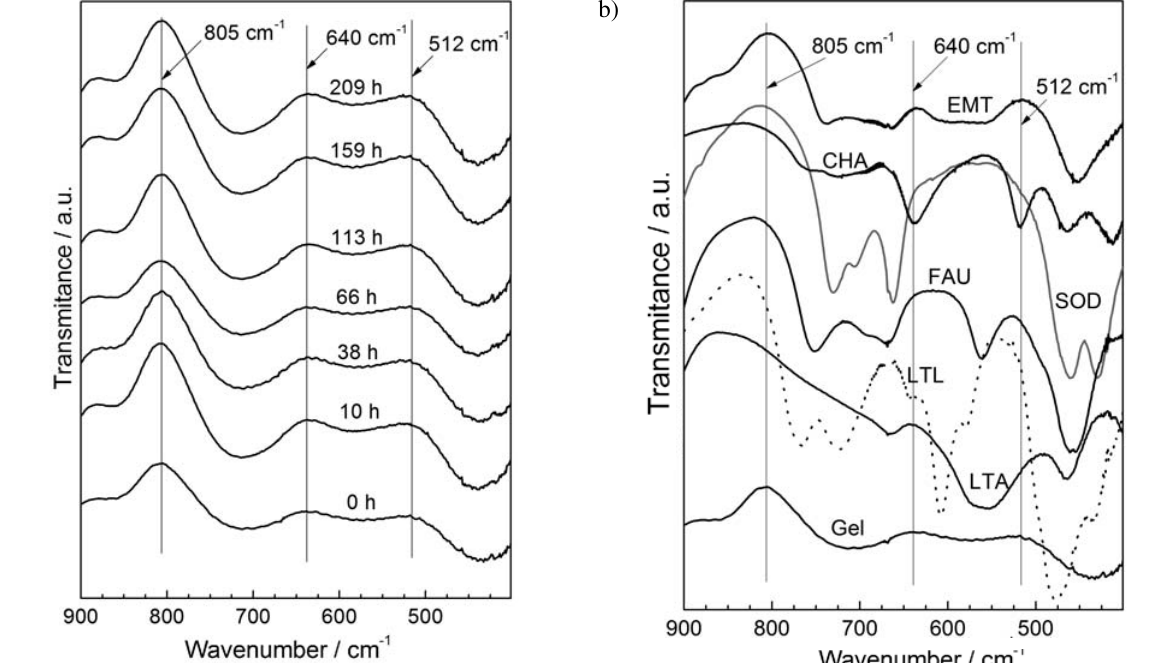
Figure 2. FTIR spectra of: a) the starting gels aged for certain time (0–209 h), and b) the typical low-silicate zeolite types: SOD (grey), CHA, EMT, LTA, LTL (dots), and FAU, recorded at 25